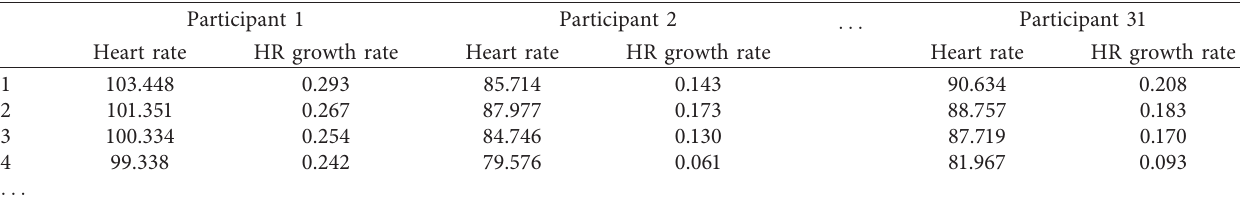
Table 2: Data of the HR value and HR growth rate.